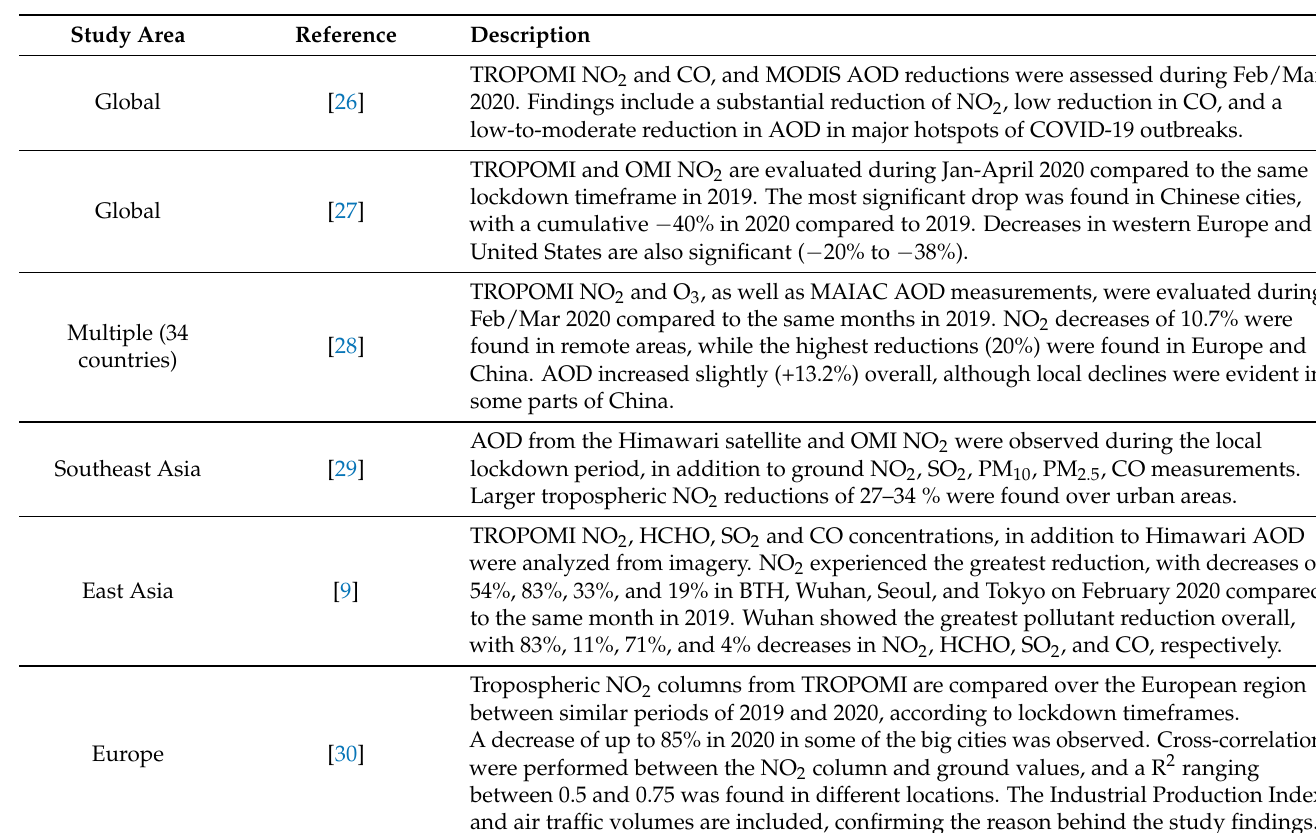
Table 1. Summary of recent studies using satellite data to investigate air pollution changes during the COVID-19 lockdown. Study